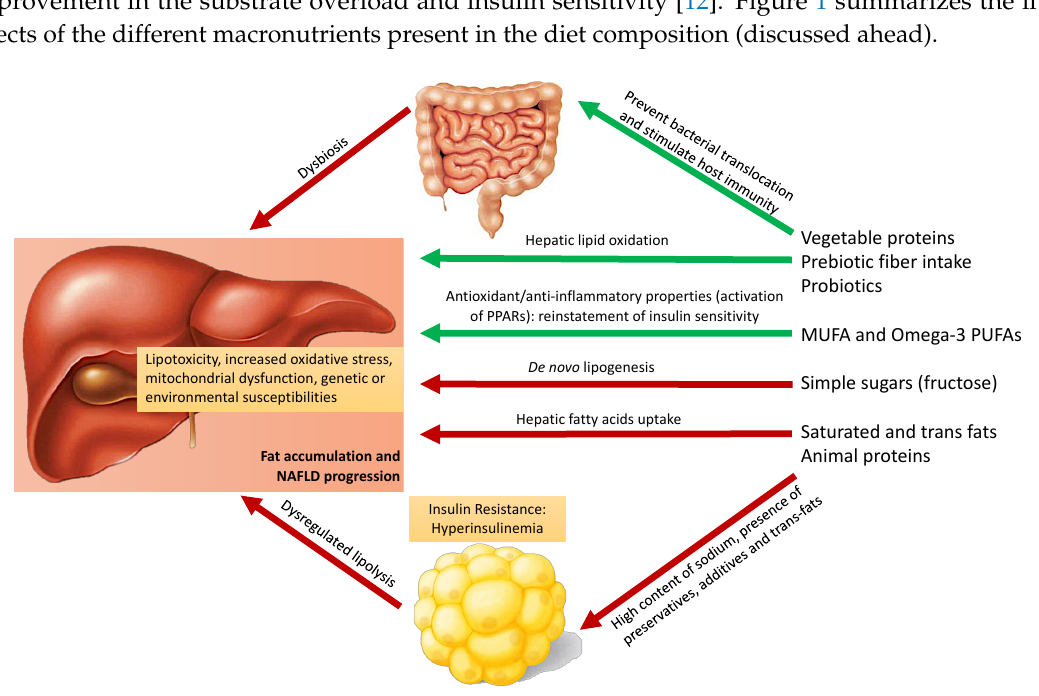
Figure 1. The effects of diverse macronutrients on non-alcoholic fatty liver disease pathophysiology. An unhealthy dietary pattern including saturated fats, trans fats, simple sugars and animal protein (red and processed meat) results in an increased total and visceral fat mass, insulin resistance, increased hepatic de novo lipogenesis and gut dysbiosis. Under these conditions and acting parallel, fat accumulates in the liver causing lipotoxicity, increased oxidative stress and mitochondrial dysfunction adding genetic or environmental predisposition for hepatic lipid accumulation (‘multiple hit hypothesis´). Red arrow: unfavorable/harmful effect; Green arrow: favorable/beneficial effect. NAFLD: non-alcoholic fatty liver disease; PPAR: peroxisome proliferator-activated